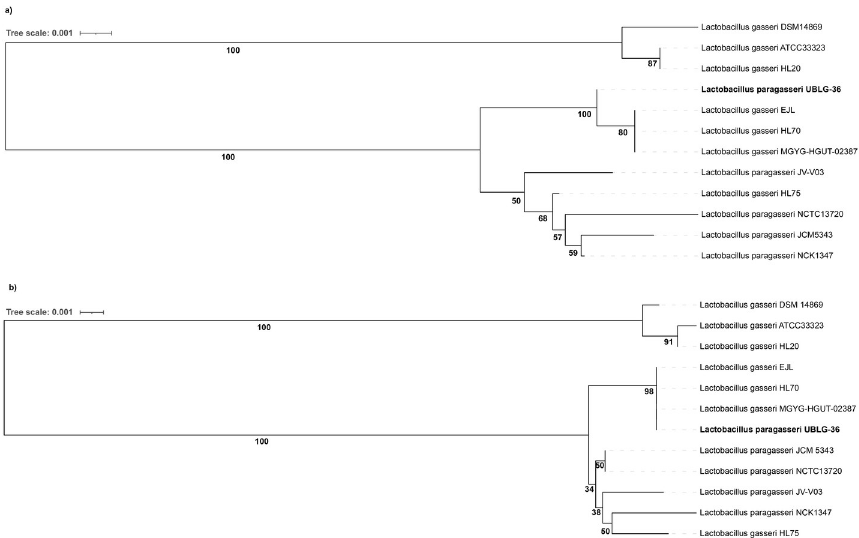
Fig 4. Relatedness of oxc and frc of Lactobacillus paragasseri UBLG-36 with all other representative genomes. (a) Phylogenetic relationship of the oxc coding sequence of Lactobacillus paragasseri UBLG-36 and other L . gasseri and L . paragasseri strains. (b) Phylogenetic relationship of the frc coding sequence of Lactobacillus paragasseri UBLG-36 and other L . gasseri and L . paragasseri strains. Phylogenetic tree construction was based on the Neighbor-Joining method with 1000 bootstrap resampling performed on MAFFT webtool. L . paragasseri UBLG-36 is depicted in bold.